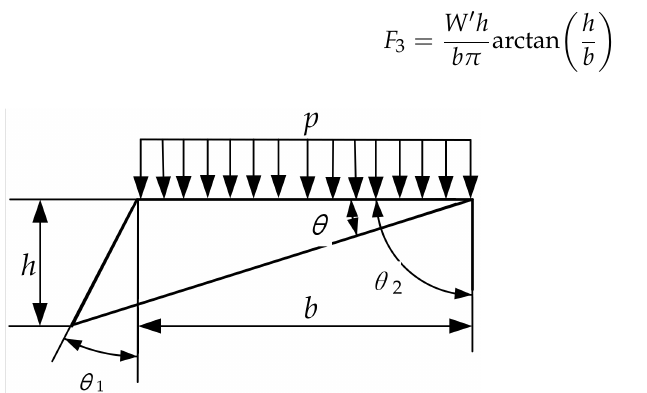
Figure 6. Stress distribution of the semi-infinite body under a band load.